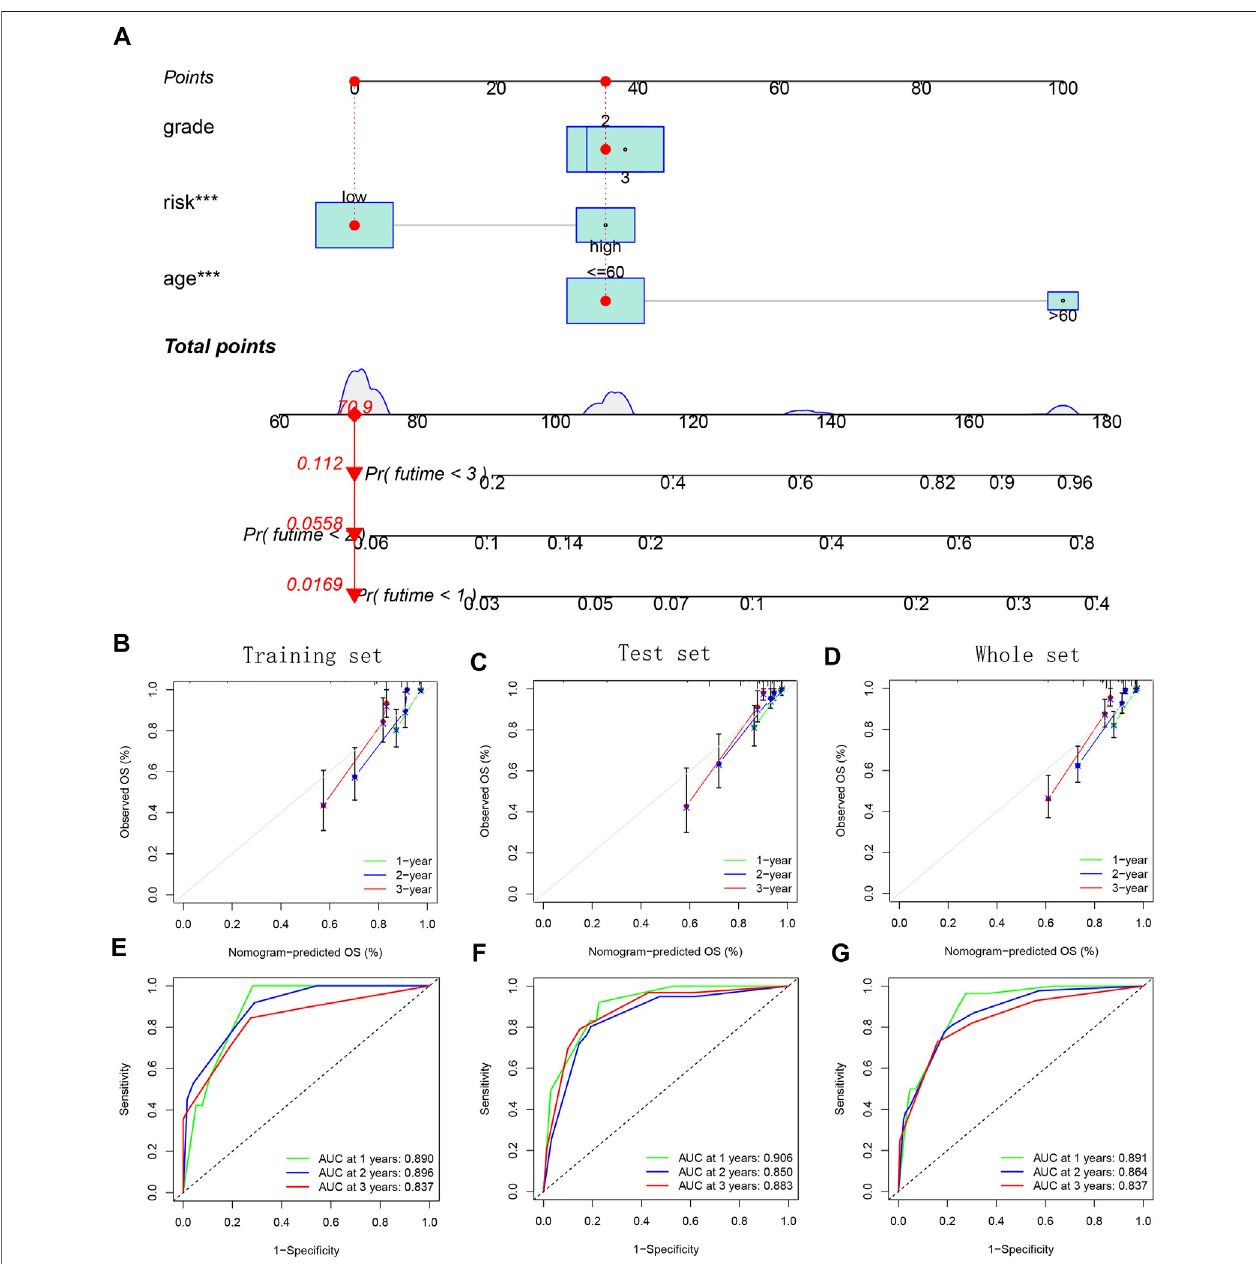
FIGURE 13 | Establishment and veri fi cation of a combined nomogram. (A) Nomogram based on age, grade, and risk group. (B – D) Internal calibration curves for verifying model ’ s prediction accuracy. (E – G) ROC curves for evaluating model ’ s prediction performance.